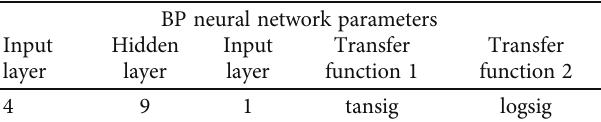
Figure 8: BP neural network structure diagram. Table 7: Relevant parameters of neural